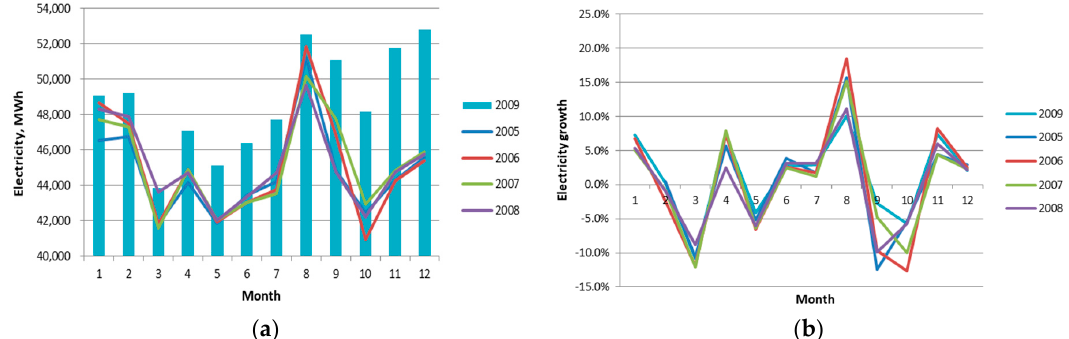
Figure 2. Monthly change: ( a ) electricity demand; ( b ) electricity growth.